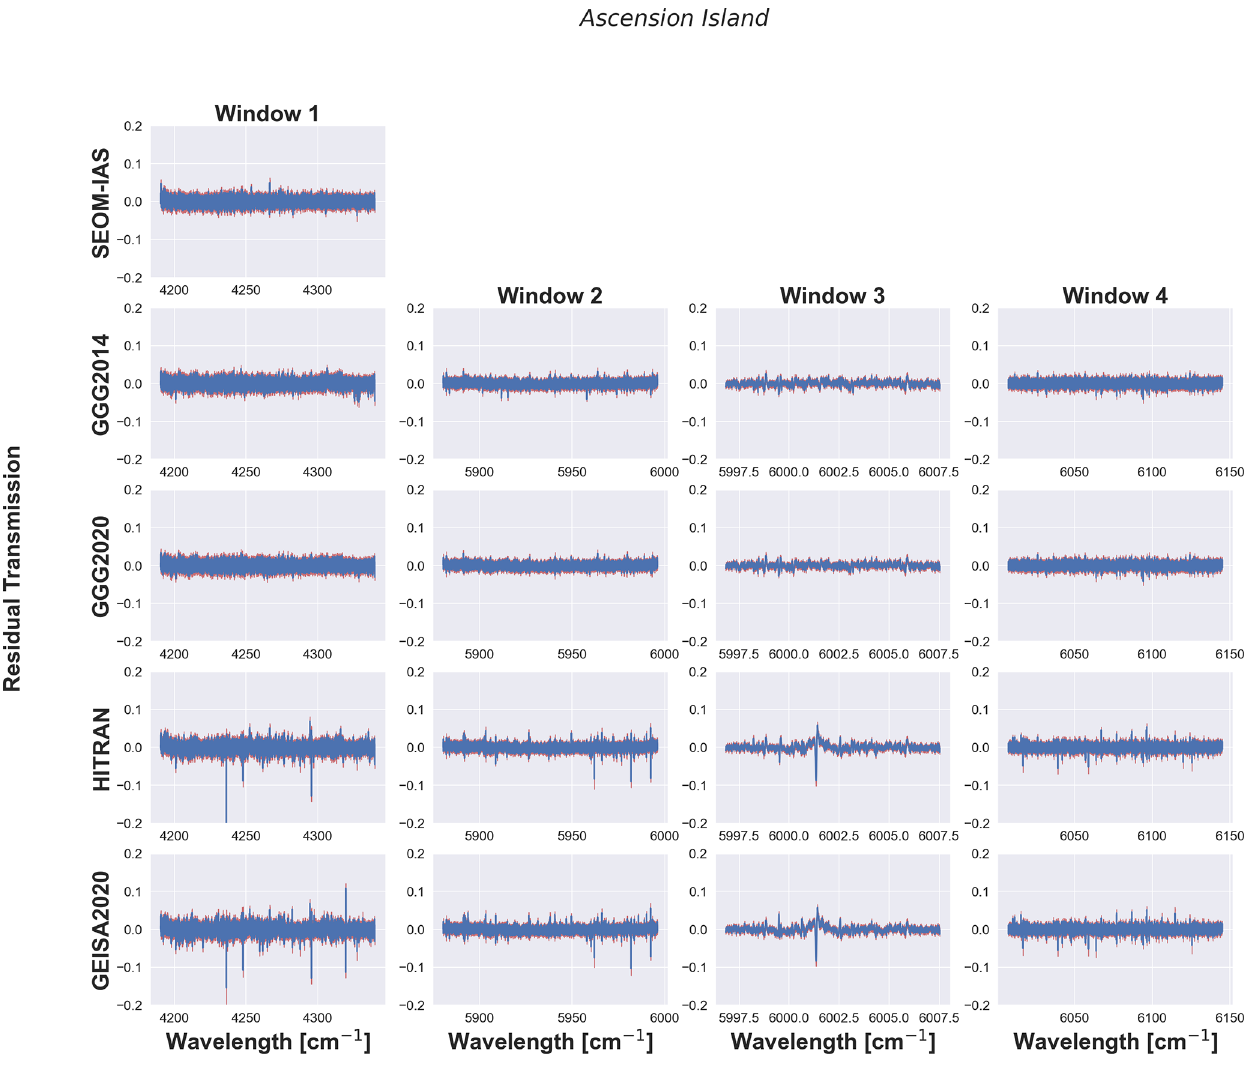
Figure A3. Example residual transmission spectra calculated from measured and fitted spectra from the Ascension Island site in